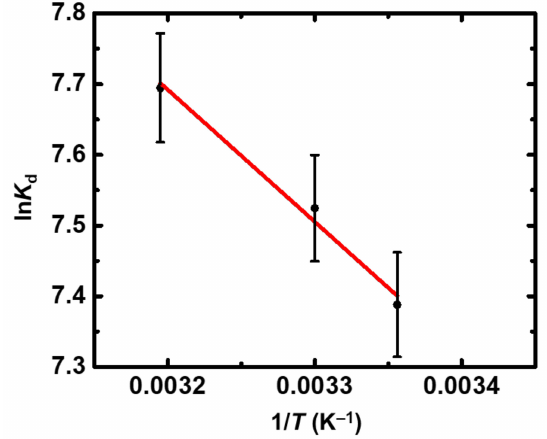
Figure 5. ln K d as a function of 1/ T for the sorption of Eu(III) by X-alginate aerogels at an initial Eu(III) concentration equal to 5 × 10 − 4 mol L − 1 . Experimental conditions are as follows: contact time 24 h, pH 3.0, adsorbent dosage 0.4 g L − 1 , agitation rate 125